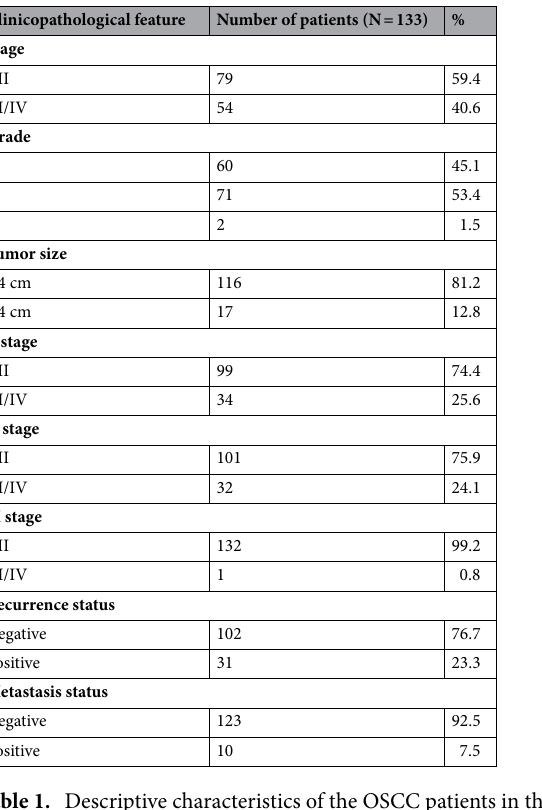
Table 1. Descriptive characteristics of the OSCC patients in the